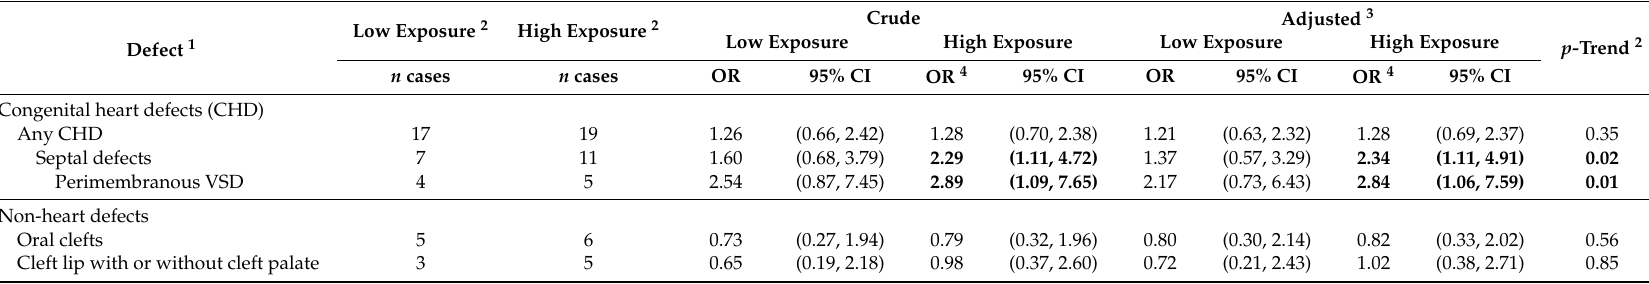
Table 3. The crude and adjusted associations between estimated cumulative oil mist exposure level and (simple) isolated birth defects, NBDPS,